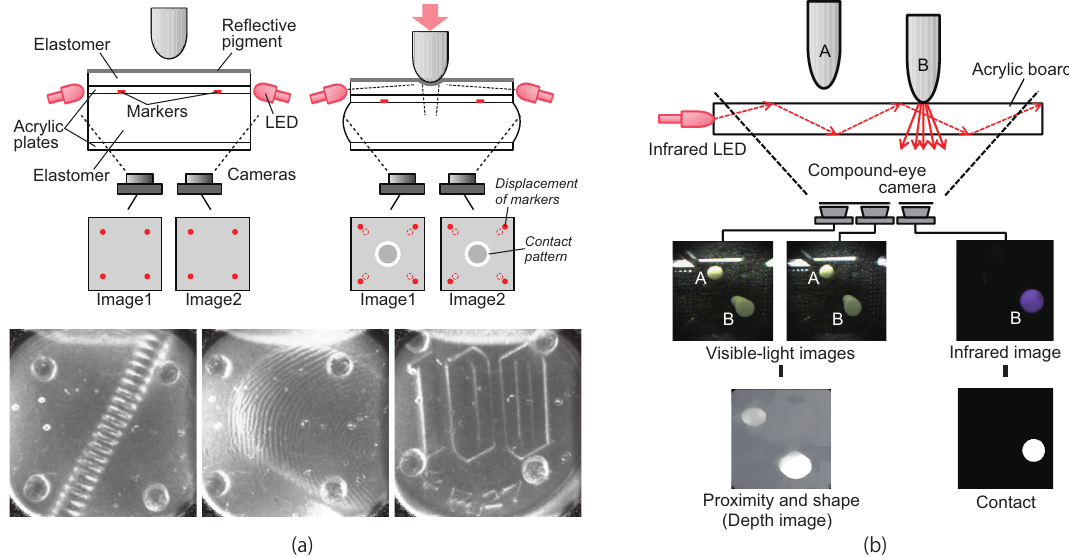
Figure 8. Examples of combined tactile image sensor. ( a ) Structure of the sensor for combined force and surface texture sensing. Force sensing and surface texture imaging is based on the marker displacement and the reflective membrane method, respectively. The bottom three images show texture images, a screw, a fingertip, and a coin ( c (cid:13) IEEE 2018. Reprinted with permission from [37]). ( b ) Combined contact and proximity sensing. Proximity and the three-dimensional shape of the object are detected from visible-light stereo pair images. Contact and its area are detected from infrared image ( c (cid:13) IEEE 2016. Reprinted with permission from [25]). A compound-eye camera, compact, and thin multiple camera system, is used to obtain both visible and infrared light images through the different optical